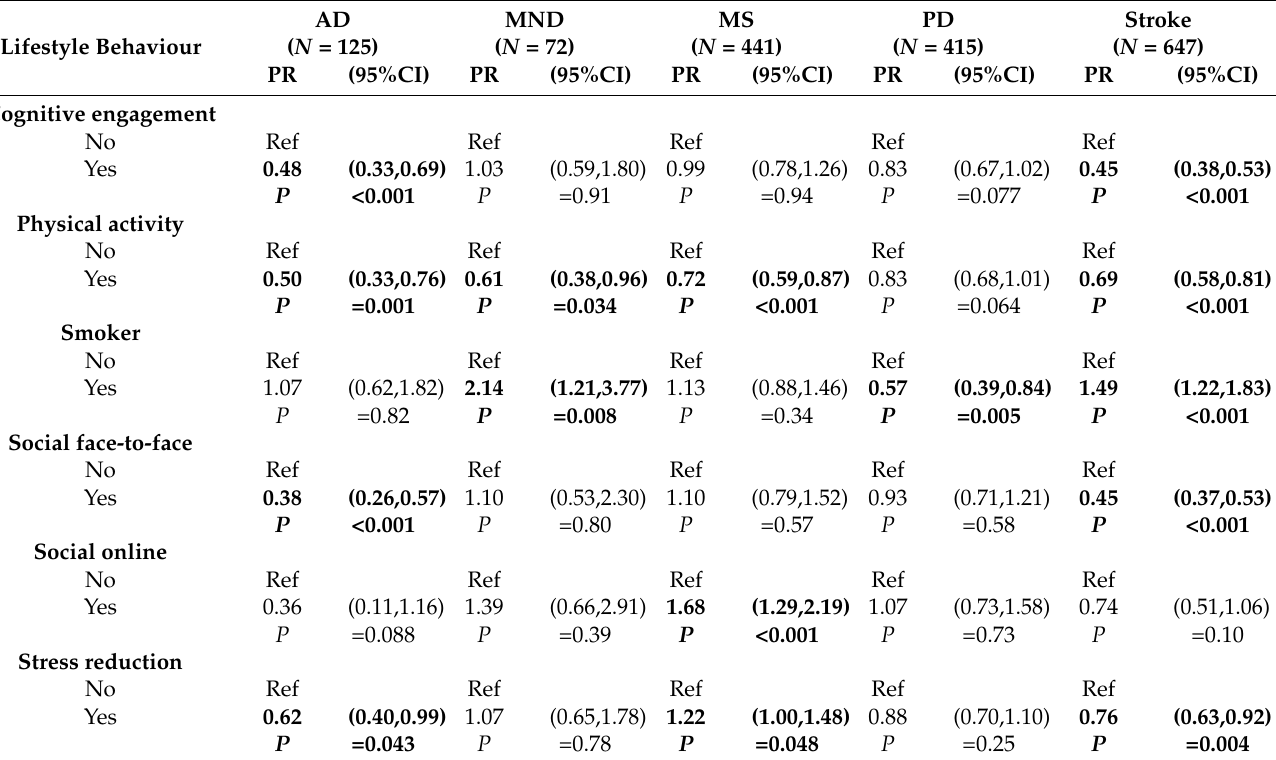
Table 4. Associations between lifestyle behaviours and neurological disorders referenced to comparator population.